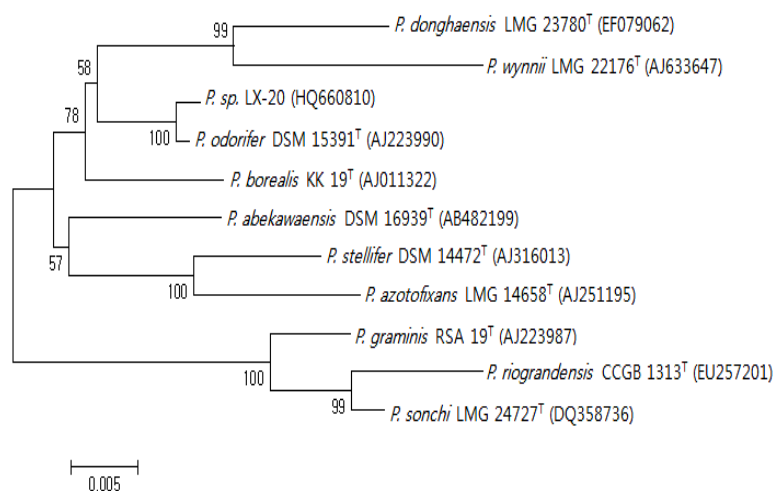
Figure 2. Phylogenic relationship of the 16S rRNA sequences of Paenibacillus sp . LX-20 with other type strains of Paenibacillus . Bootstrap values (based on 1,000 trials and only values >50%) are shown at the nodes. The GenBank accession numbers are indicated in parentheses. Bar denotes 5-base substitutions per 1,000 nucleotide position. P. is an abbreviation of Paenibacillus .